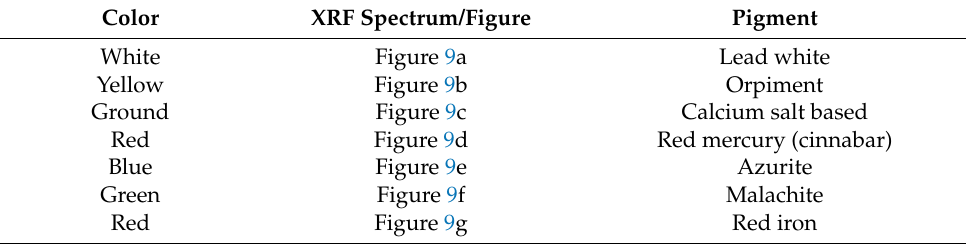
Table 1. Sampled colors from the imperial gates and identified pigments (based on Figure 9).